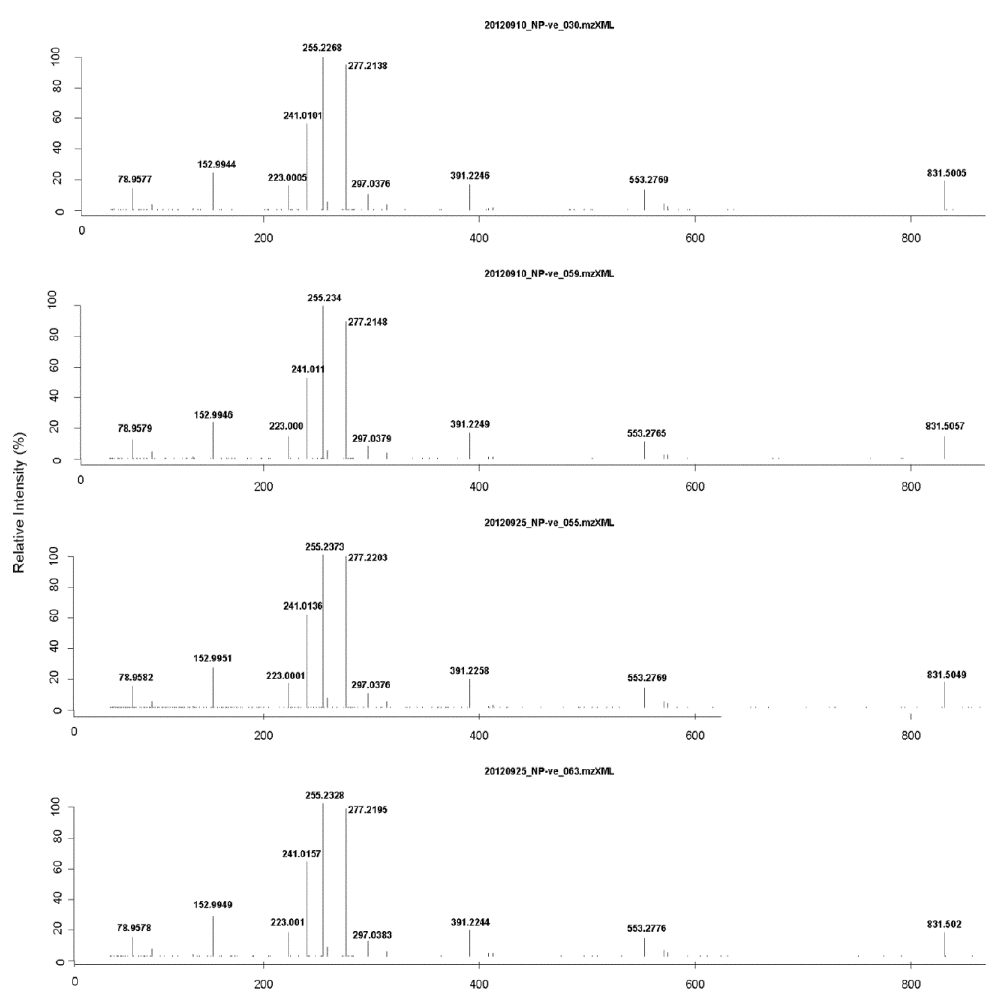
Figure 4. The centroid MS 2 spectra of m/z 831.5050 [M-H] − computed from four ryegrass samples, with the number of MS 2 scans included in the computation from each sample being of n = 15, 14, 10, 10. The four computed MS 2 spectra are highly correlated (with r > 0.9) and the fragment ions suggest they are highly consistent across samples (with distMS2 score < 0.15). Each of the ions labeled can be matched with the theoretical fragment ions from the Lipid Maps database. Besides the top 5 ions discussed in the text regarding the second sample, m/z 831.5057 is shown as the pseudo molecular ion (deprotonated), and ion; m/z 223.000 as inositol phosphate ion with the loss of H O; m/z 78.9579 as a PO 3 2 m/z 297.0379 as glycerophosphoinositol with the loss of 2H O; and m/z 553.2765 2